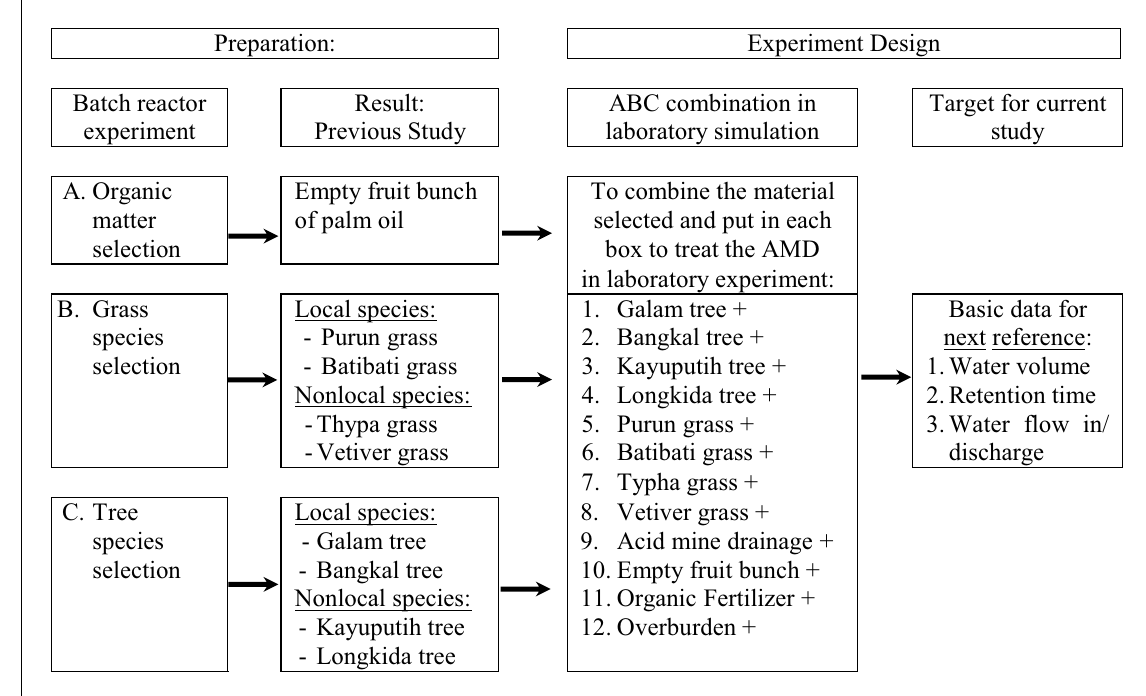
Table 1. Experimental design for laboratory simulation.